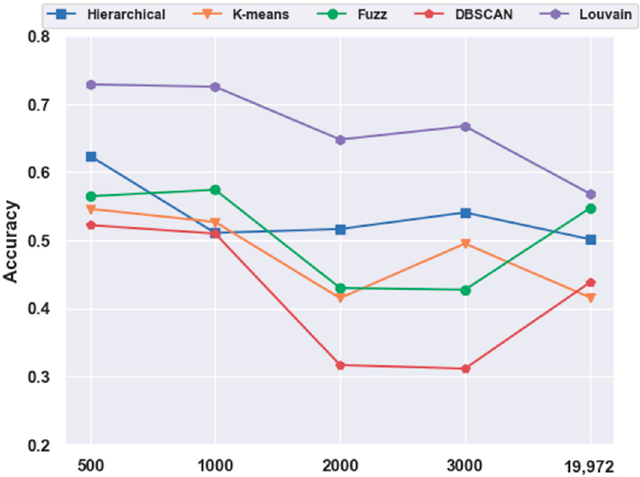
Figure 1. Effectiveness of feature selection on mouse cortex data. Hierarchical, K-means, Fuzz, DBSCAN, and Louvain represent hierarchical clustering, K-means, fuzzy C-means, density-based spatial clustering, and Louvain algorithms, respectively.